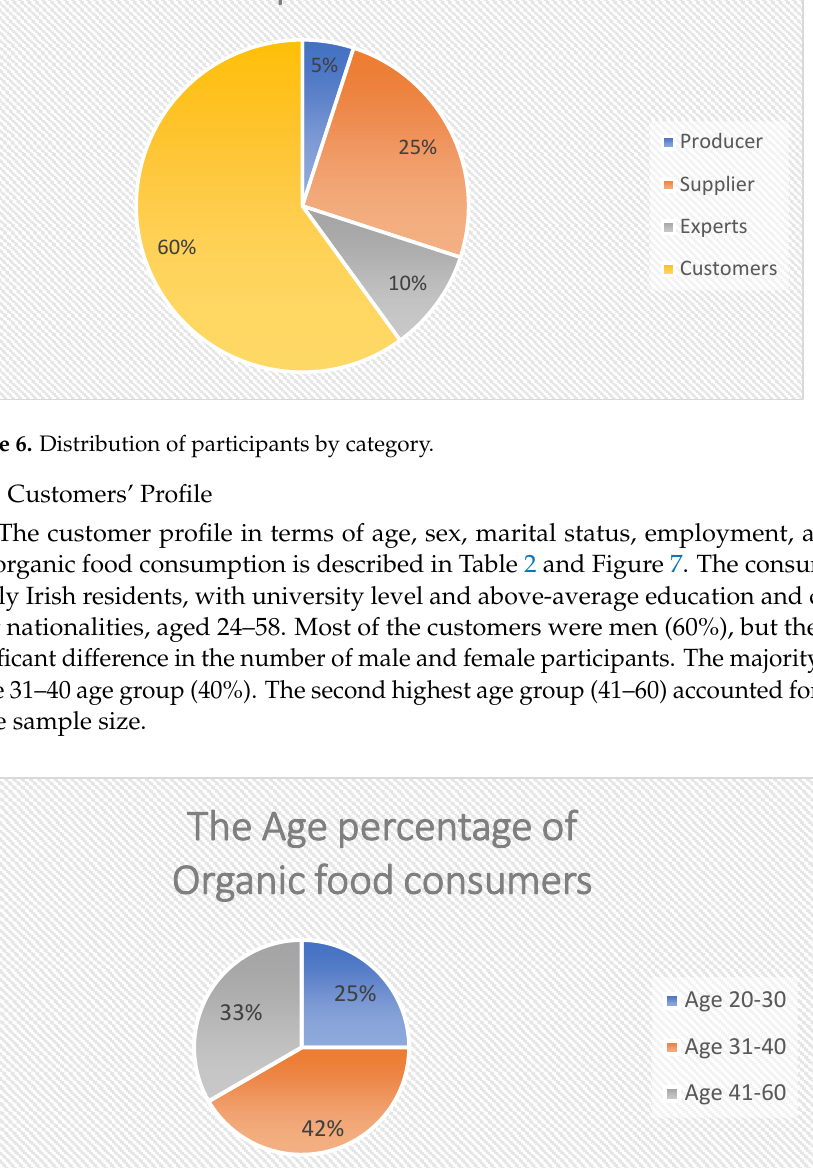
Figure 7. Distribution of organic food consumers by age.